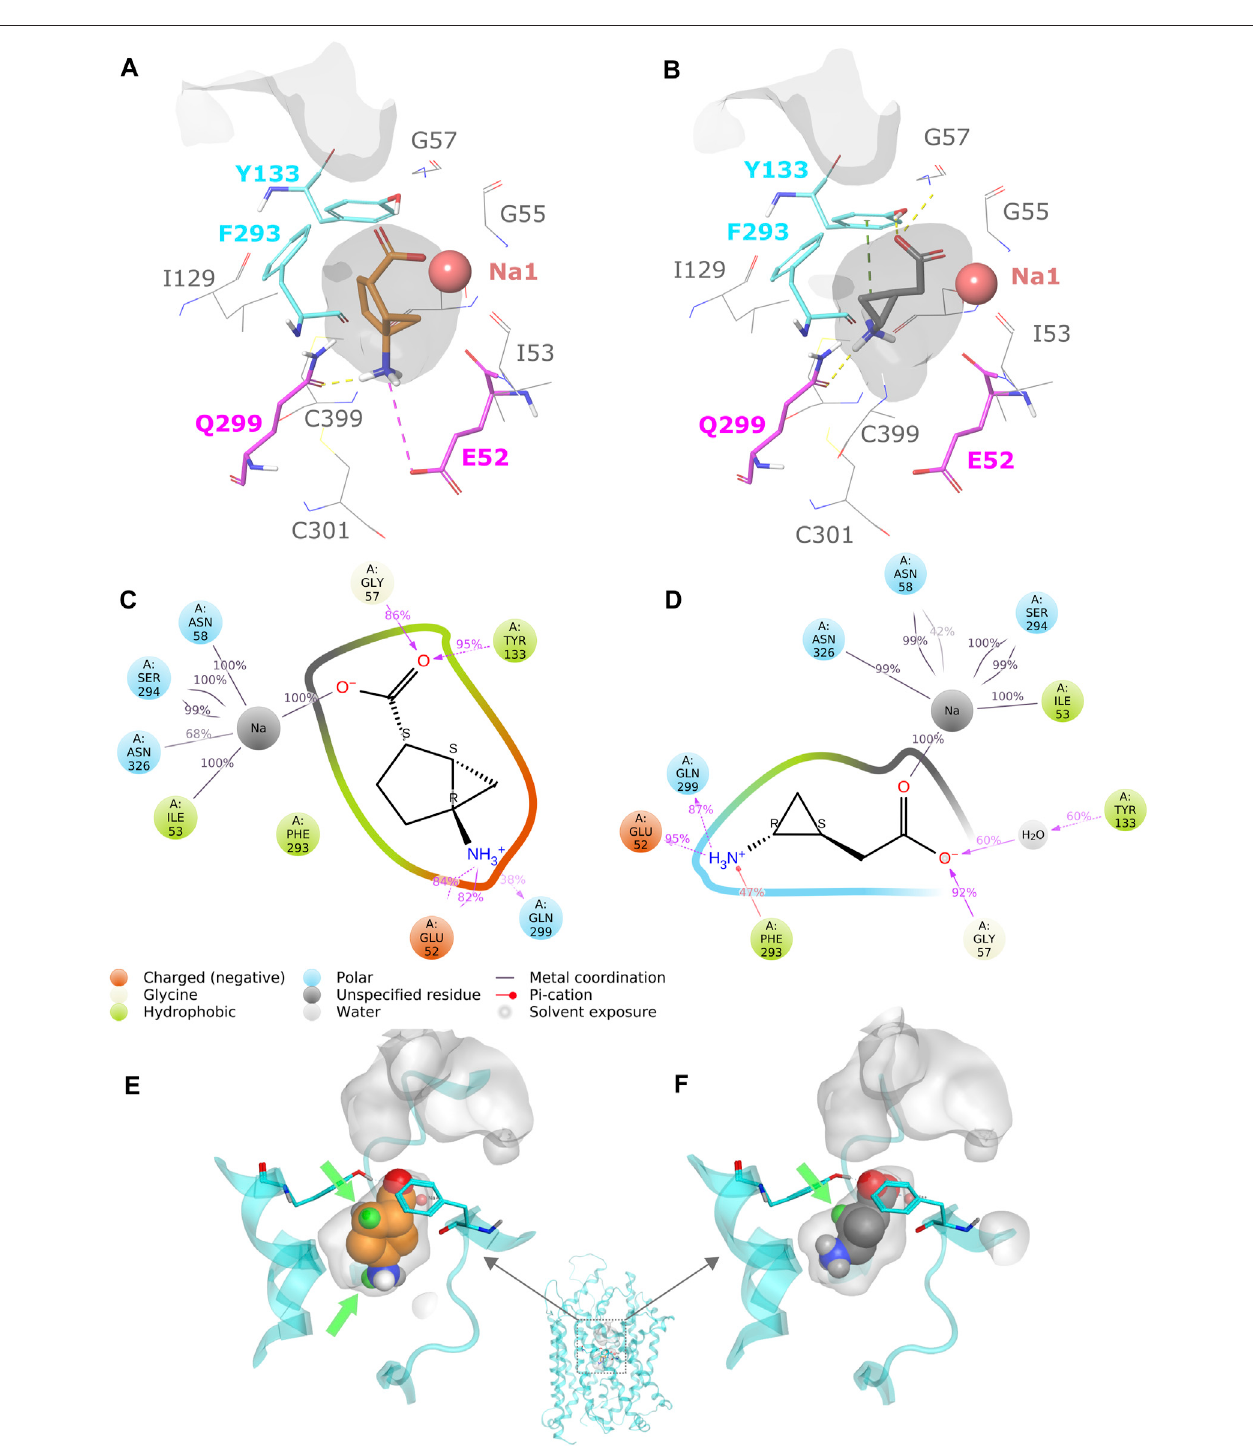
FIGURE 2 | (A) Protein – ligand interactions of the most promising docking pose of bicyclo-GABA. The residues E52 and Q299 are highlighted in magenta and the extracellular lid residues F293 and Y133 are highlighted in cyan. The pocket surface is depicted in grey. (B) Protein – ligand interactions of the most promising docking pose of 1 . (C) Protein – ligand interaction schematic overview of bicyclo-GABA after 100 ns of MD simulations (see also Supplementary Figure S3 ). (D) Protein – ligand interaction schematic overview of 1 after 100 ns of MD simulations (see also Supplementary Figure S4 ). (E) Available pocket space for the docking pose of bicyclo-GABA. The pocket surface is depicted in grey. Green spheres represent the selected derivatization positions. The extracellular lid residues are depicted in cyan. (F) Available pocket space of the docking pose of 1 .